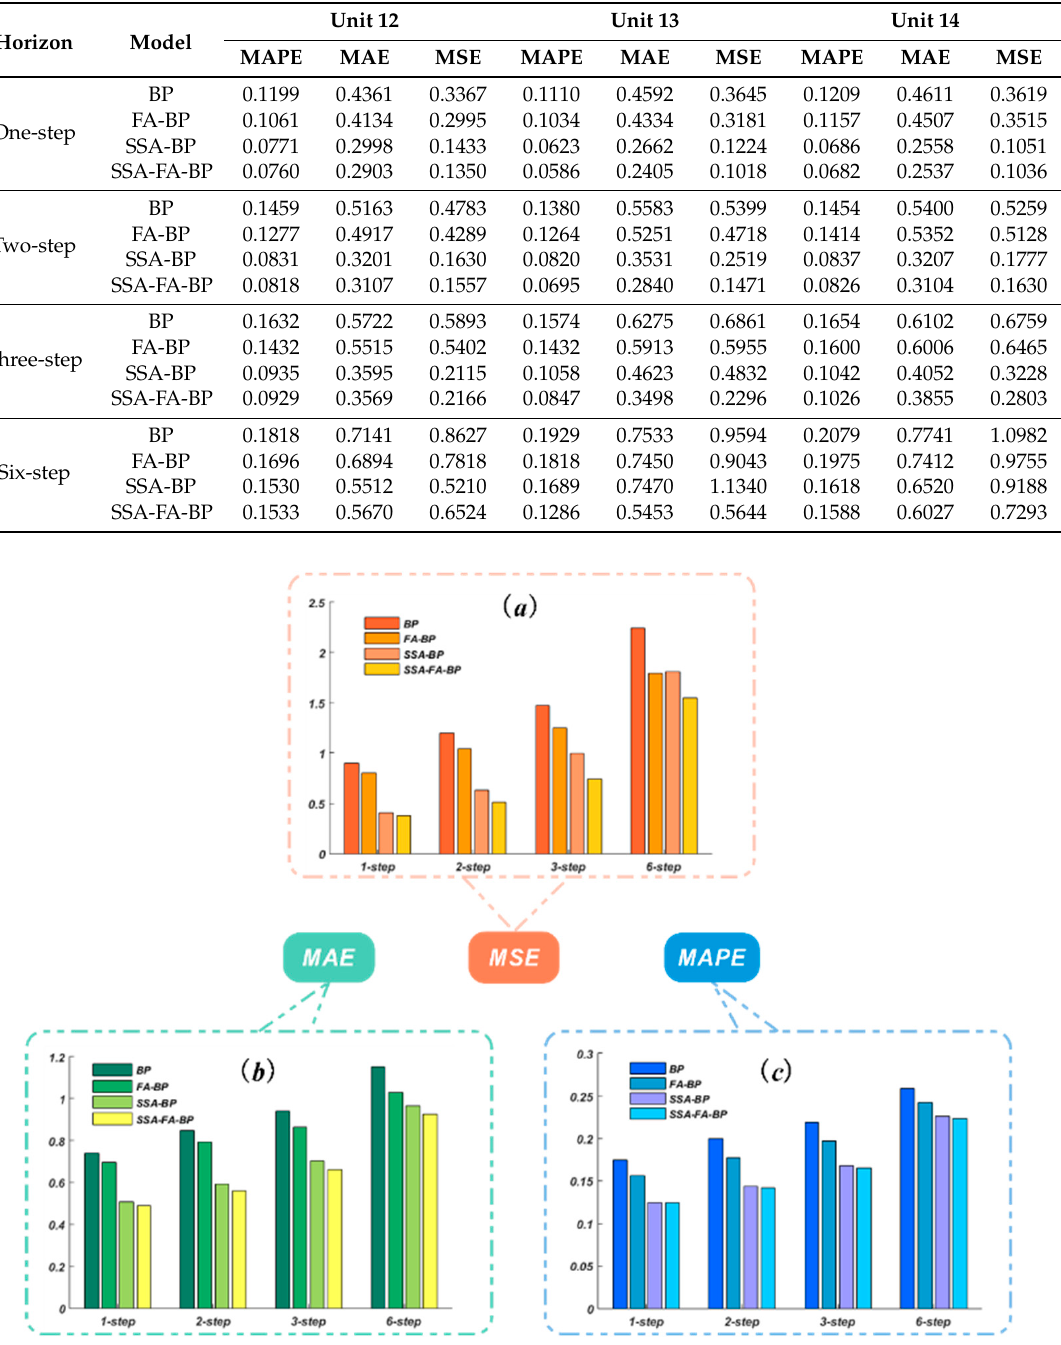
Figure 8. The multiple ‐ steps forecasting accuracy indexes of Unit 12 (30 min), ( a ) refers to the result of MSE; ( b ) refers to the result of MAE; ( c ) refers to the result of MAPE).